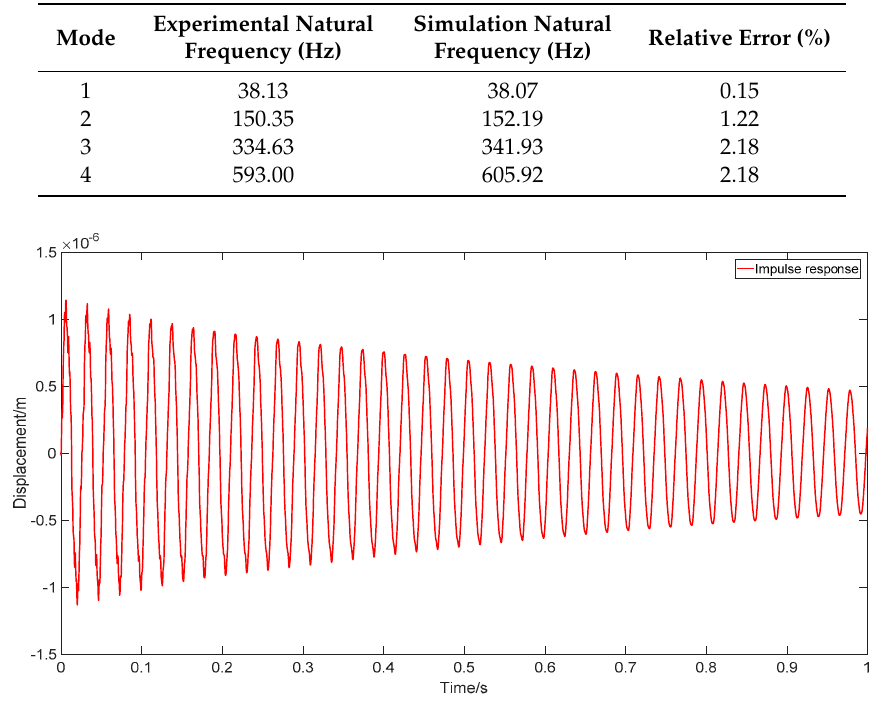
Figure 28. The impulse response diagram of the simply supported beam.